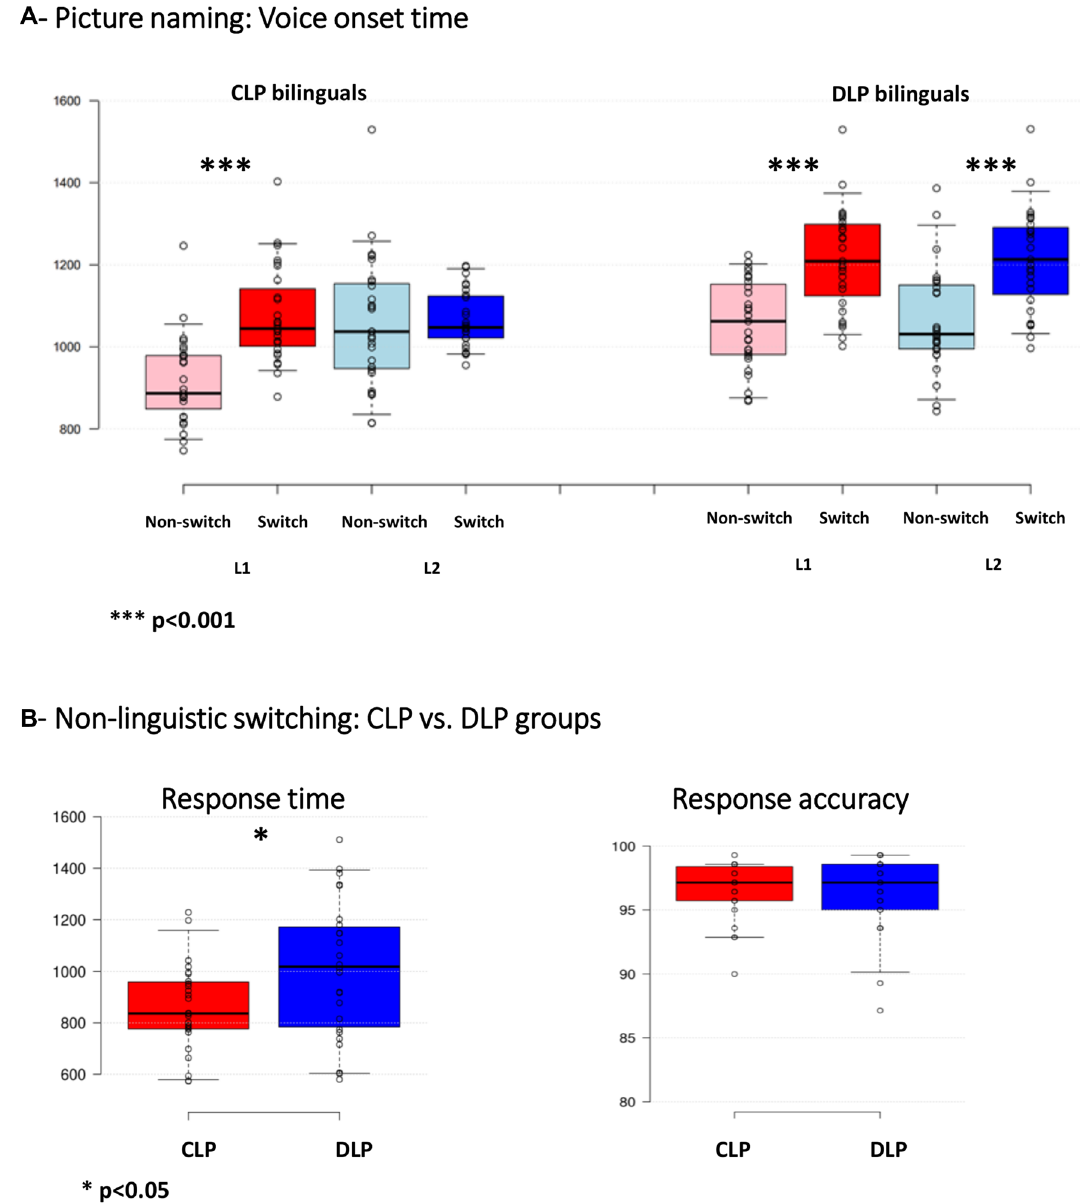
Figure 2. Behavioral results; ( A ) Picture-naming voice onset time. ( B ) Nonlinguistic switching task, response accuracy and response